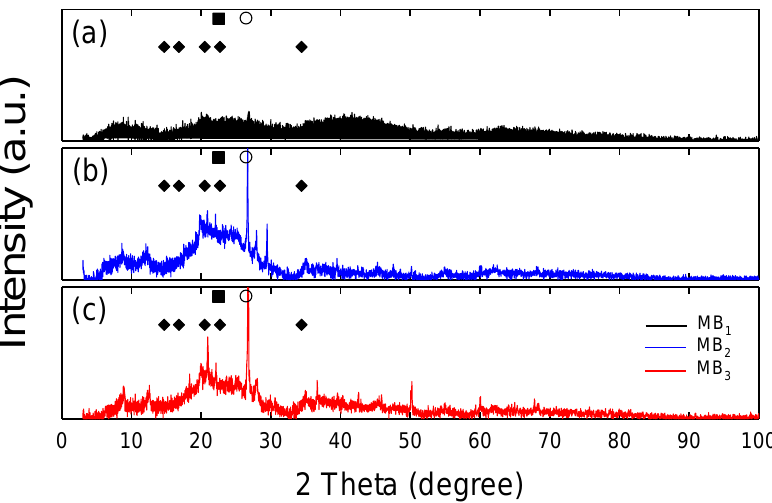
Figure 4. XRD patterns of harvested MB samples ( a ) MB 1 ; ( b ) MB 2 ; and ( c ) MB 3 . ■ denotes a SiO 2 peak, ○ denotes an Al peak, and ◆ denotes a cellulose І peak.